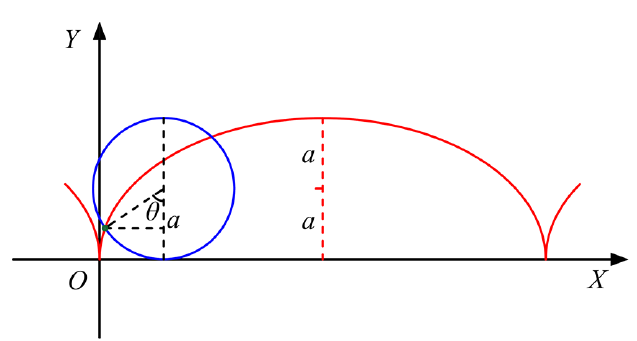
Figure 1. Schematic diagram of the brachistochrone.